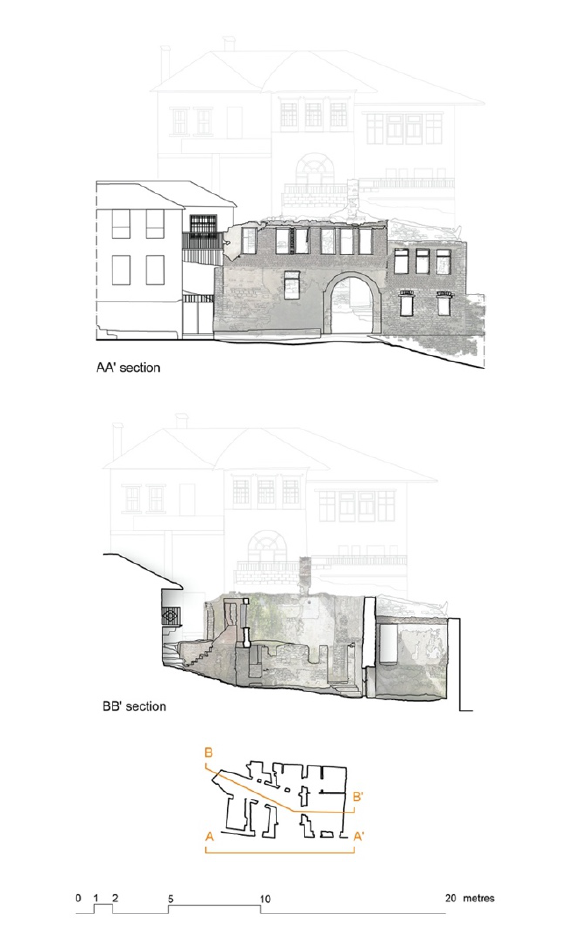
Figure 8. Cross sections and main façade of Dalipi ruins (Survey: K. Neli, J. Lamaj, E. Miho, J. Zajmi, M. Ballanca. Graphic editing: E. Lamacchia).